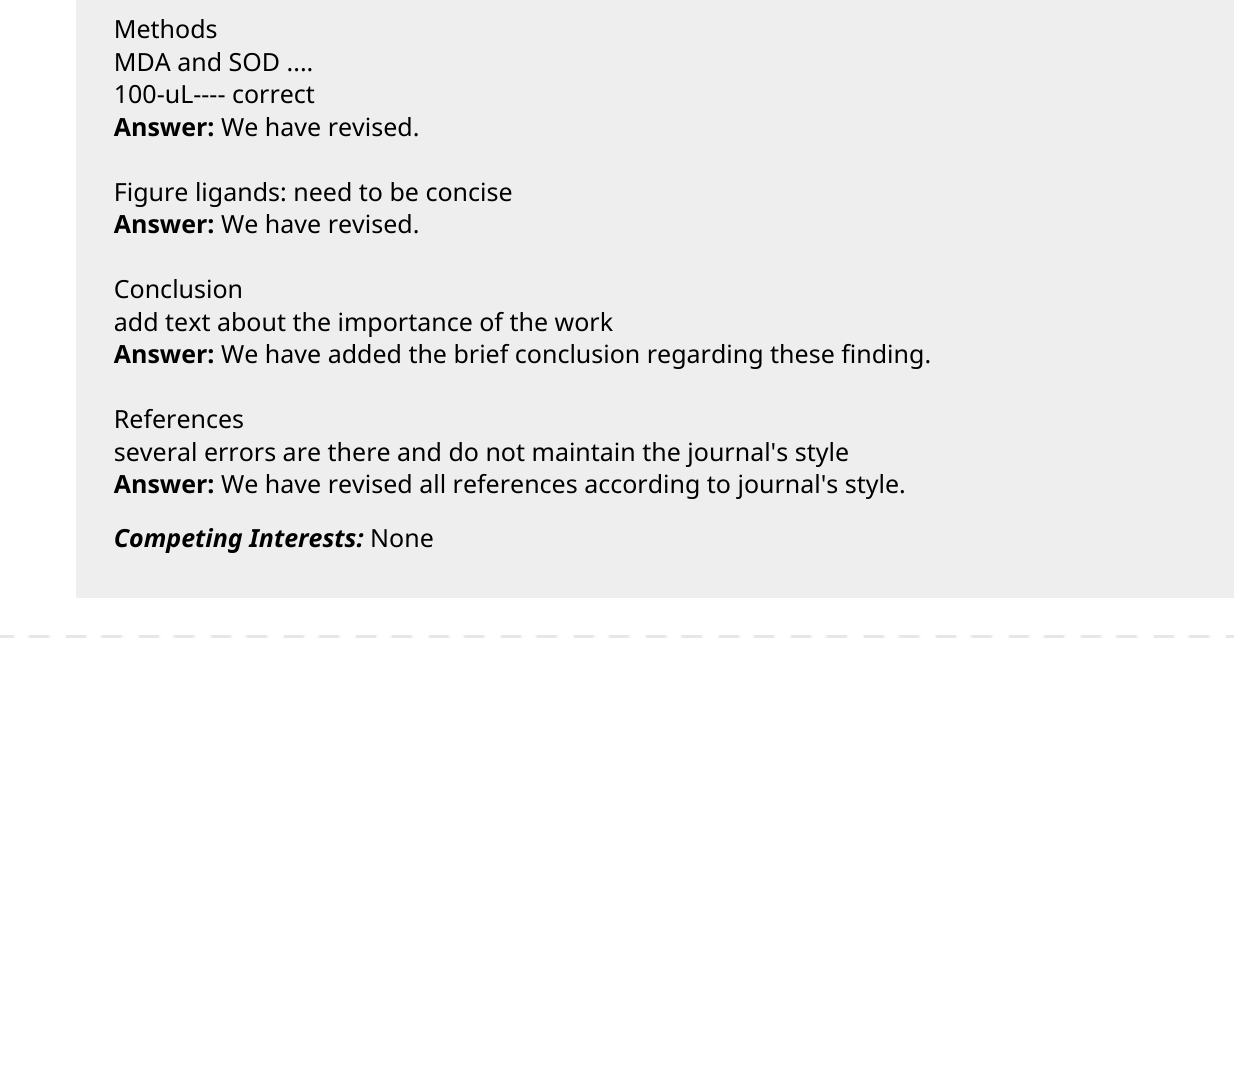
Figure ligands: need to be